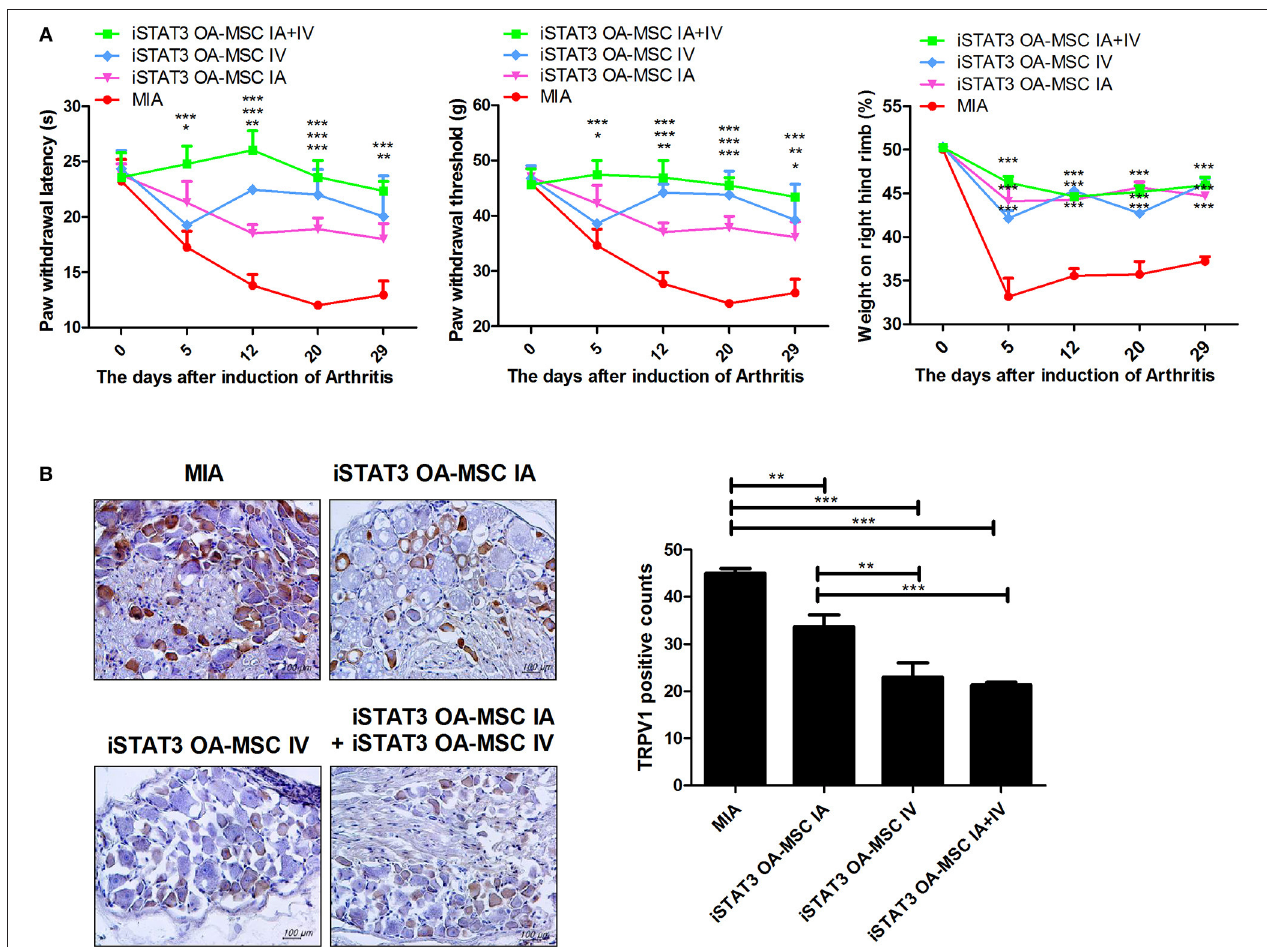
FIGURE 4 | Additive effects of pain relief by IA and IV co-administration of iSTAT3 OA-MSCs in MIA-induced OA rats. (A) OA was induced in Wistar rats by IA injection of MIA. OA rats were injected with IA and IV iSTAT3 OA-MSCs (each 3 × 10 5 , final 6 × 10 5 per rat). OA-MSC were isolated of fat tissues obtain from each four person with OA. Pain behavior was assessed as mechanical hyperalgesia measured with a dynamic plantar esthesiometer and incapacitance meter, and was quantified as PWL and PWT ( n = 3 per group). (B) Immunohistochemical staining was used to identify the expression of TRPV1 in the dorsal root ganglion of OA rats. * P < 0.05, ** P < 0.01, *** P <